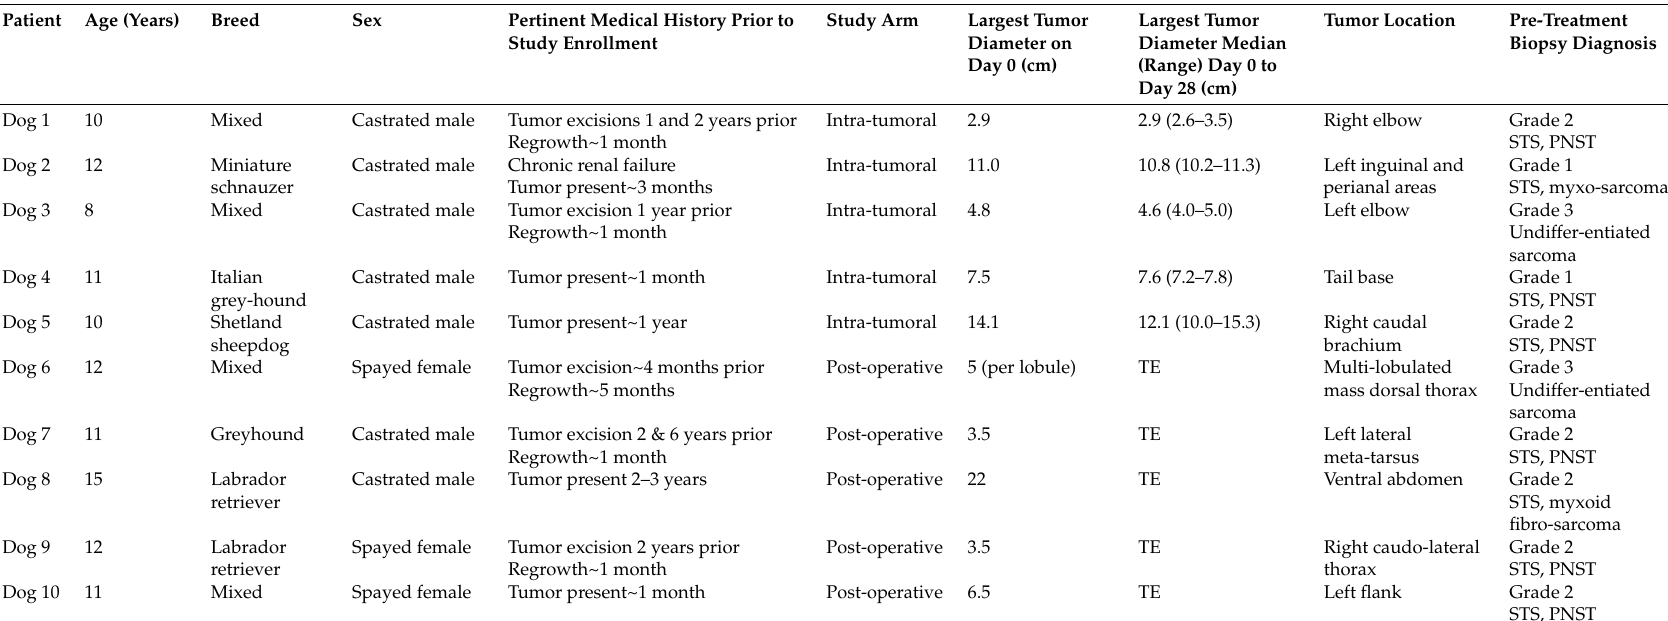
Table 2. Patient information and